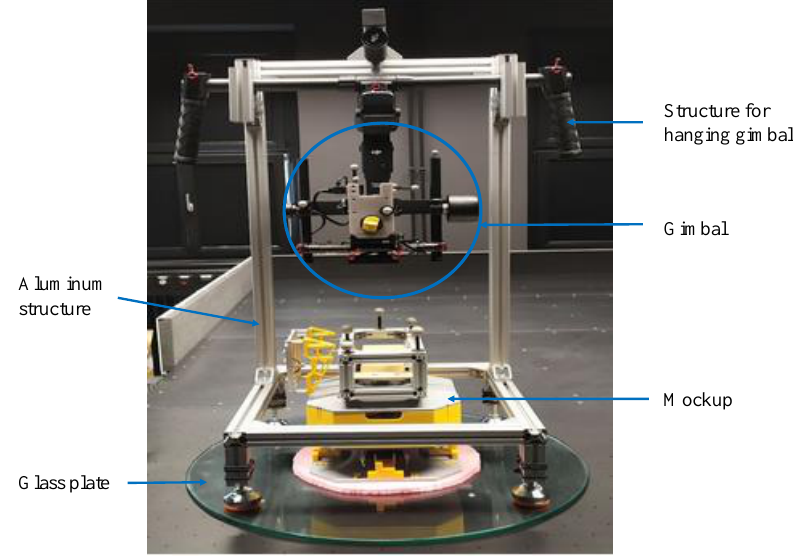
Figure 16. Gimbal